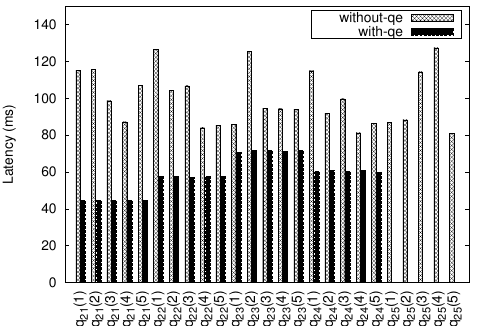
Figure 18. Average latency for each query